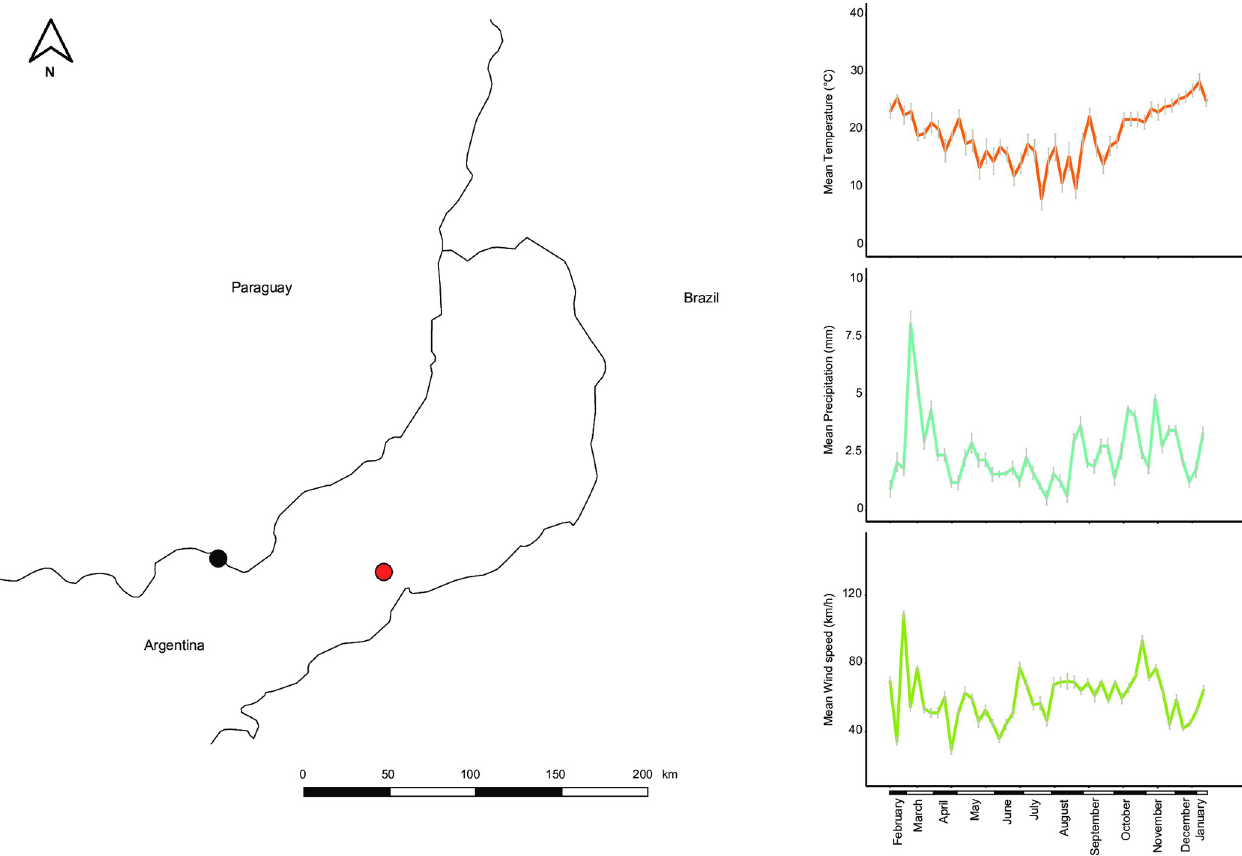
Fig 1. Map of the study area in Misiones province, Argentina. The location of the Centro de Investigaciones Antonia Ramos (CIAR), where the Malaise trap was deployed, is indicated by a red dot. The location of the weather station is indicated by a black dot. The insets to the right show the variation in the climatic variables throughout the sampling period (shown in more detail in S1